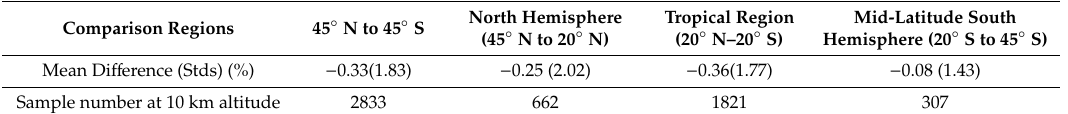
Figure 12. The COSMIC-2 fractional refractivity mean di ff erences and standard deviation compared to those collocated RS41 profiles from June to October 2019 ( a ) over global (45 ◦ N to 45 ◦ S), ( b ) mid-latitude North Hemisphere (45 ◦ N to 20 ◦ N), ( c ) tropical region (20 ◦ N–20 ◦ S), and ( d ) mid-latitude South Hemisphere (20 ◦ S to 45 ◦ S). The mean biases and standard deviation relative to the mean are computed from surface to 30 km altitude. The sample numbers are in the blue line, the mean di ff erences are in red line, and the standard deviation values are in green line.